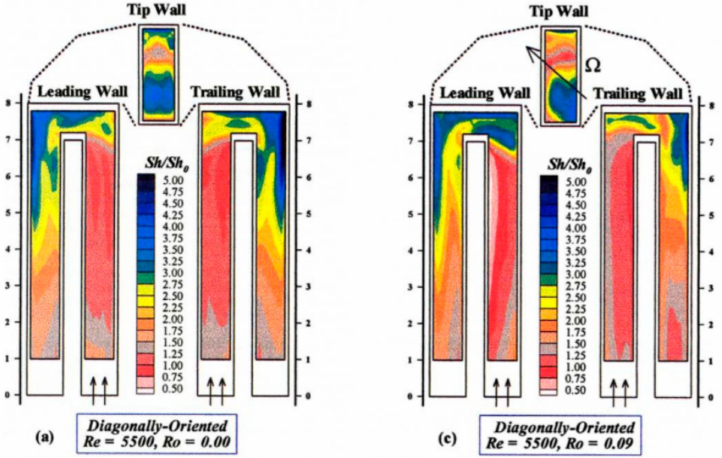
Figure 9. Local Sherwood Number ( Sh ) ratio ( Sh / Sh 0 ) under stationary ( left ) and rotating conditions ( right ) [35] Reprint with permission from ASME (order number